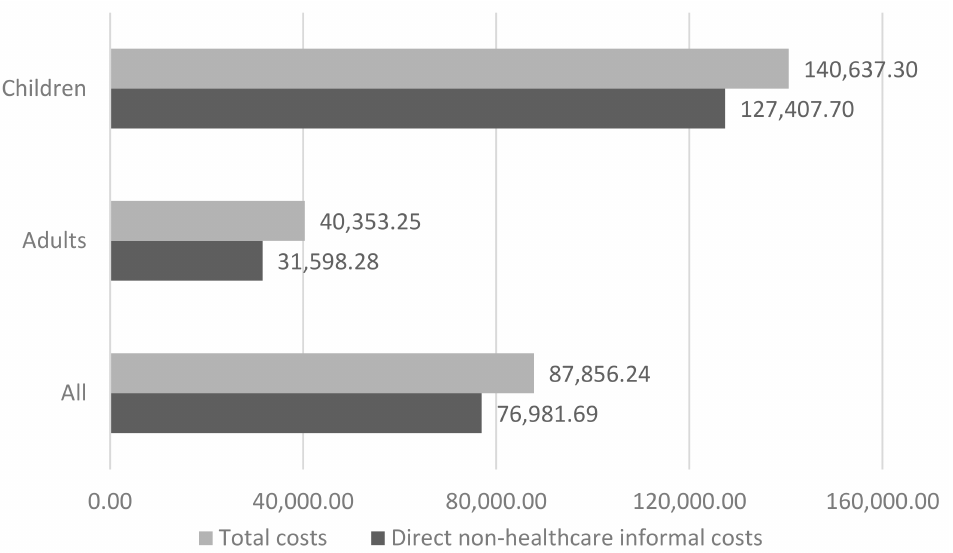
Figure 4. Direct non-healthcare costs related to informal care and total costs in children, adults and all patients (2017, €